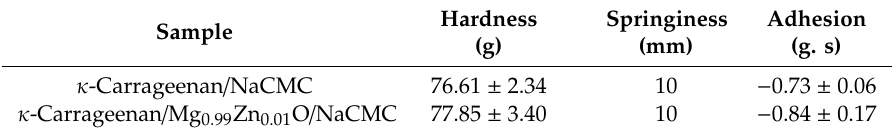
Table 1. Compression test of the hydrogels.